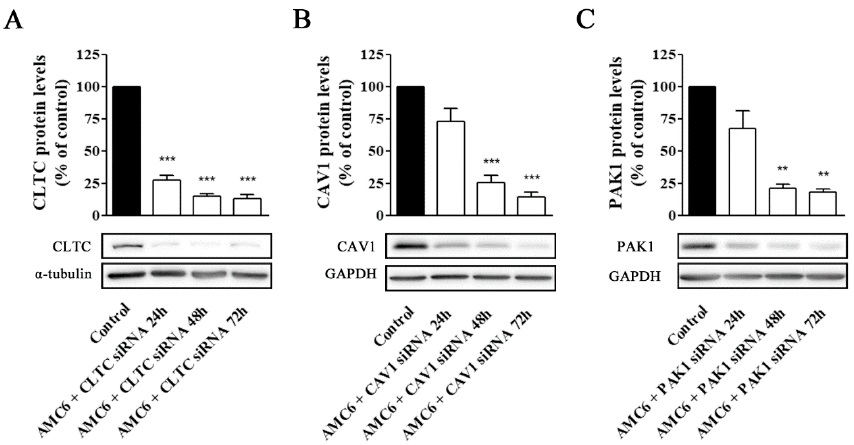
Figure 5. Time-course of AMC6/custom siRNA against CLTC, CAV1 and PAK1. Cells were treated with vehicle (control) for 72 h, and AMC6 (1 µM) complexed to CLTC ( A ), CAV1 ( B ) and PAK1 ( C ) targeting siRNA (50 nM) for 24, 48 and 72 h; The graph shows the ratios between the optical densities of CLTC and α -tubulin ( A ) CAV1 and GAPDH ( B ) and PAK1 and GAPDH ( C ), expressed as percentage in comparison to the vehicle (control). Western blot images belong to a representative experiment. Data are expressed as the mean ± SEM of 3 individual experiments. ** p < 0.01; *** p < 0.001 as compared to control.